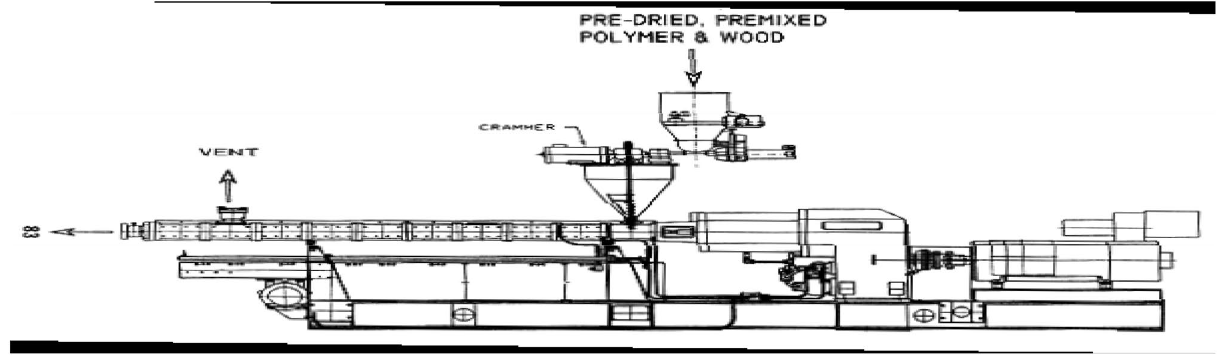
Figure 2. Premix